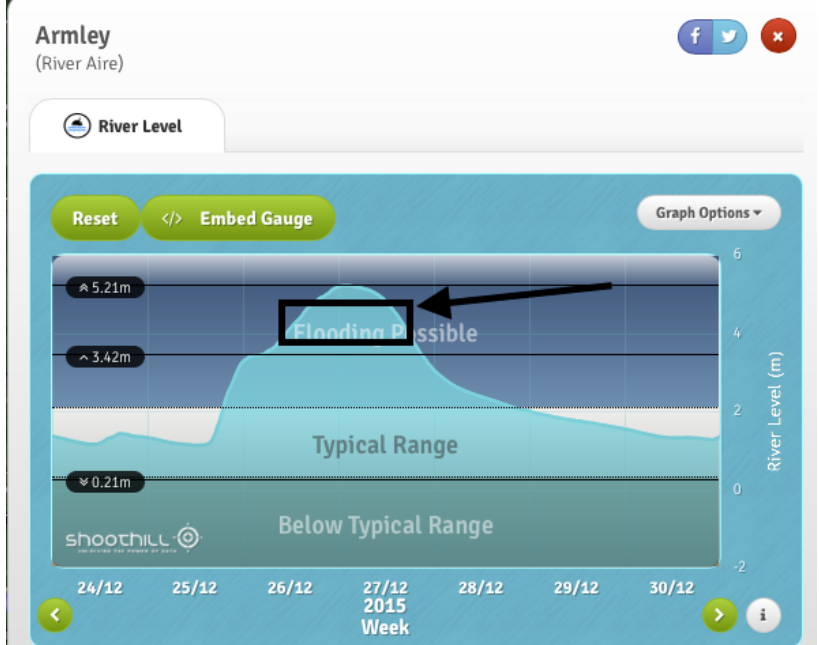
Figure 6. By using Gaugemap (http://www.gaugemap.co.uk) at the Armley station, one can quickly estimate the river level of the mean area indicated by the top rectangle above h T = 3.9 m, which yields a mean height at the arrow of about 4.7 m; by using the online time slider, one can also also find the duration T f ≈ 32 h for which the flood level was above h T